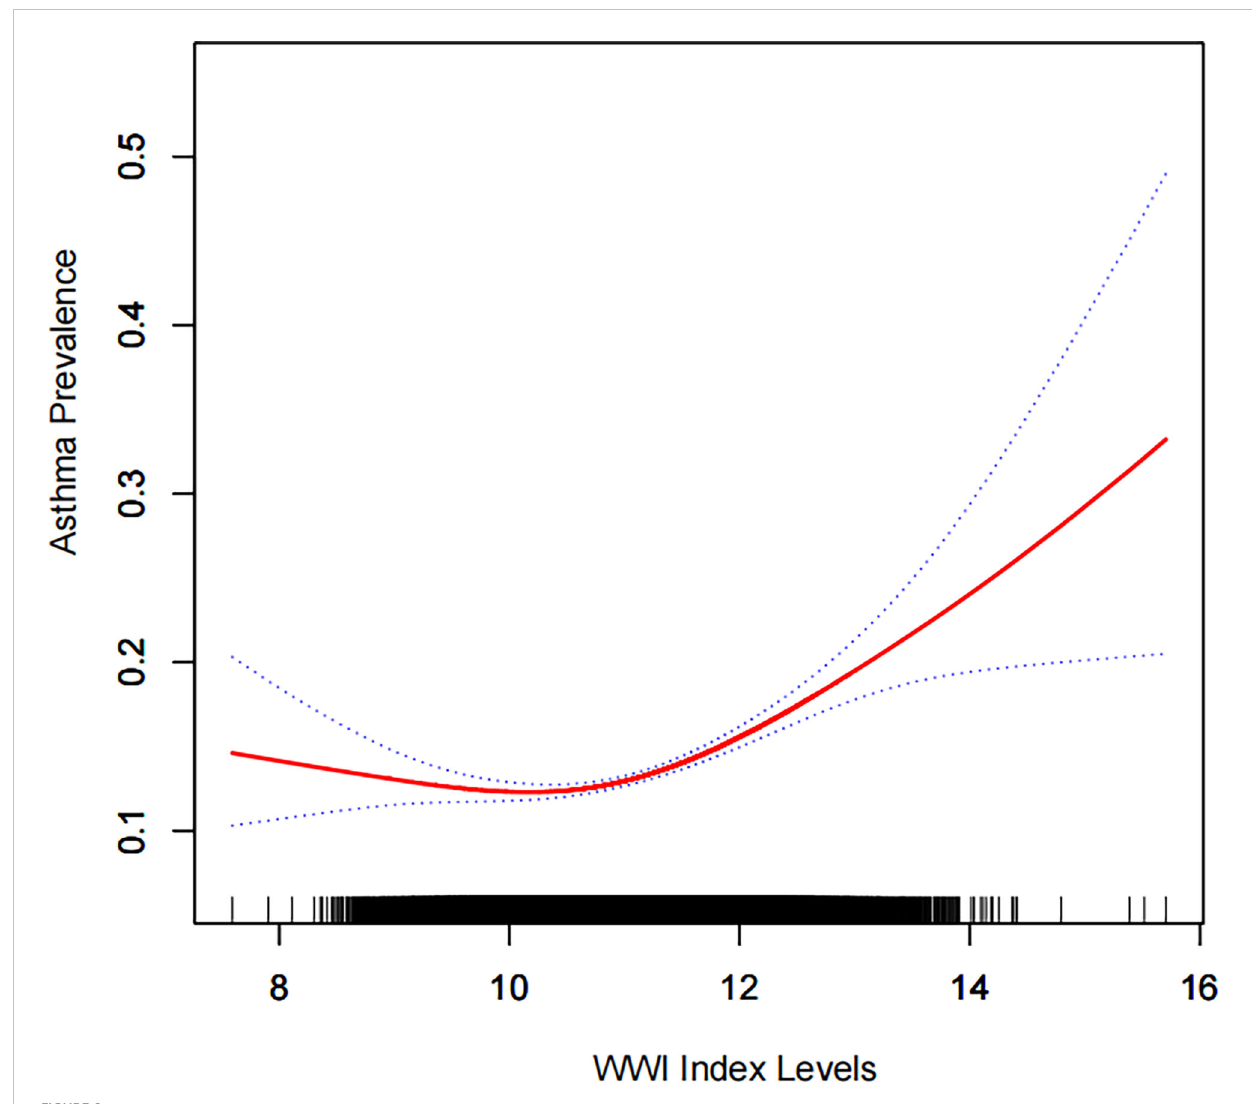
FIGURE 2 Density dose-response relationship between WWI index with asthma prevalence.The area between the upper and lower dashed lines is represented as 95% CI. Each point shows the magnitude of the WWI index and is connected to form a continuous line.Adjusted for all covariates except effect modi fi er.